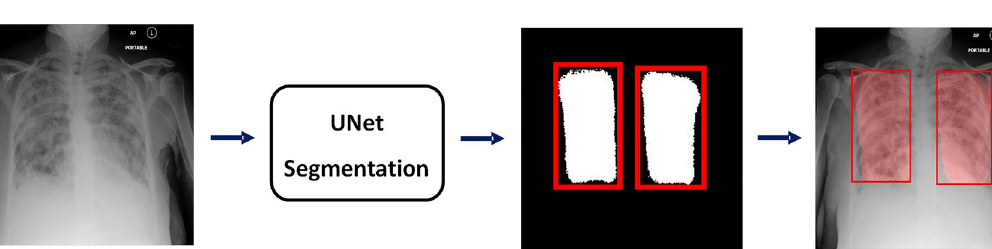
Figure 2. Images and labels corresponding to the five examples introduced in the Fig. 1.